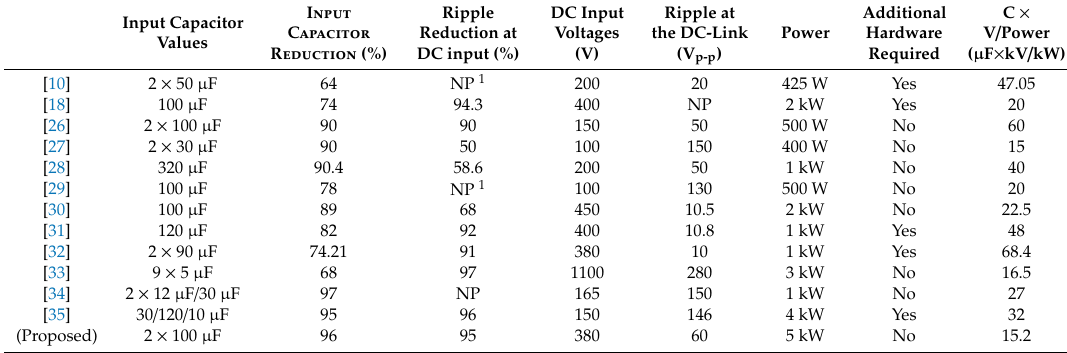
Figure 14. ( a ) Comparison of the ripple reduction with and without the double line frequency ripple controller. ( b ) Prototype hardware e ffi ciency profile with respect to di ff erent load power. Table 4. Comparison of the reduction of 120 Hz ripple at the DC